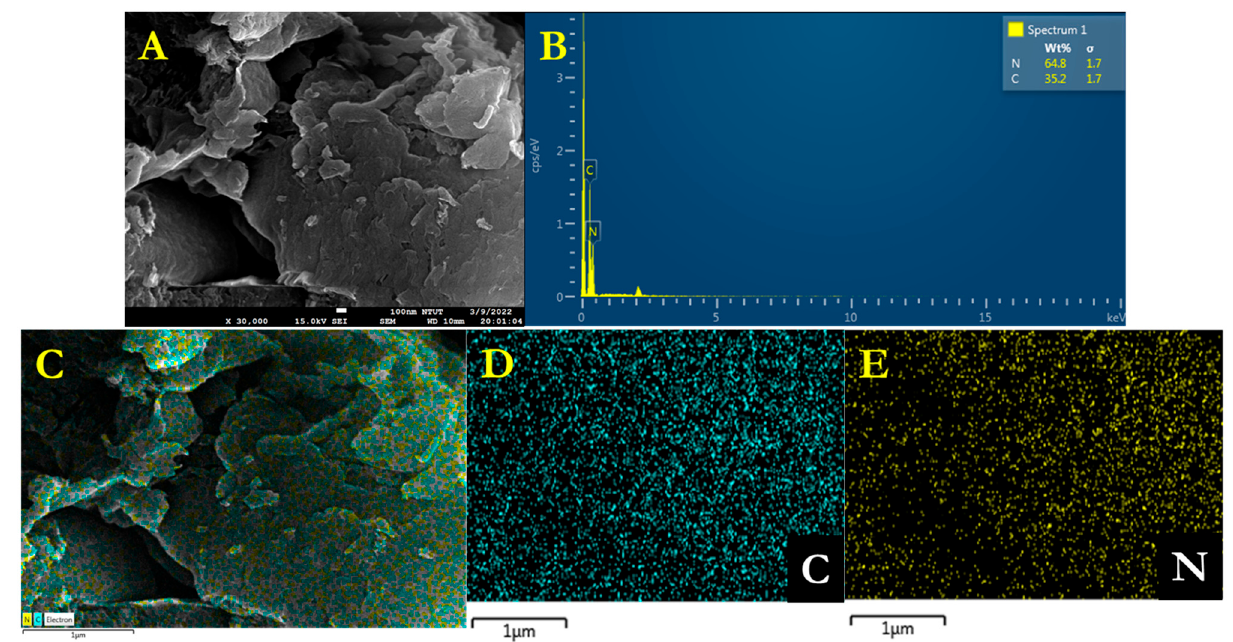
Figure 3. EDX ( A , B ) and elemental mapping images ( C – E ) of the as-synthesized g-C 3 N 4 photocatalyst.